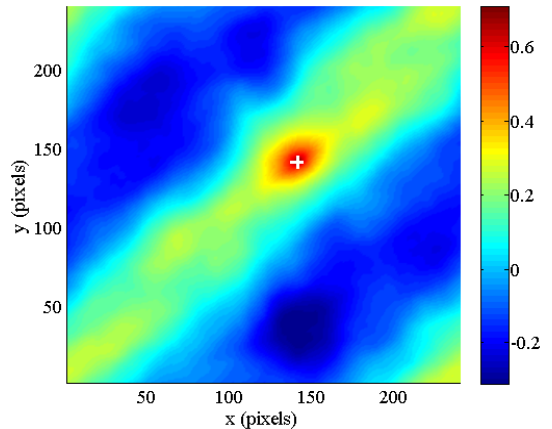
Figure 10. Cross-correlation map corresponding to a rotation angle of − 21° clockwise and a scale of 0.98 times the size of the original image. The image is 240 × 240 pixels instead of 256 × 256 pixels, due to the change of